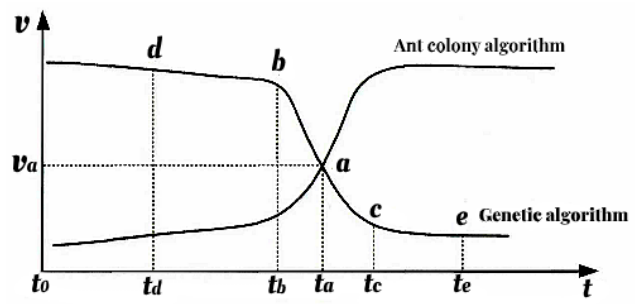
Figure 2. Speed–time curve of the genetic algorithm and ant algorithm.